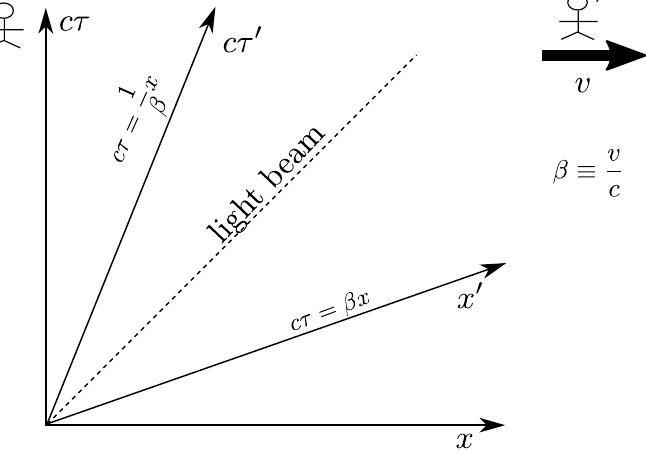
Fig. 4. A stationary (unprimed) and a moving observer (primed) represented, respectively, by two sets of coordinate axes: ð x ; c (cid:1) Þ and ð x 0 ; c (cid:1) 0 Þ . The primed observer moves with velocity v in the positive x -direction. The time dimension is scaled by the speed of light c , so that the path traversed by a photon bisects the unprimed axes. Due to the light speed invariance, the same photon path must also bisect the primed axes. For clarity, only one spatial dimension is shown, but the other two are